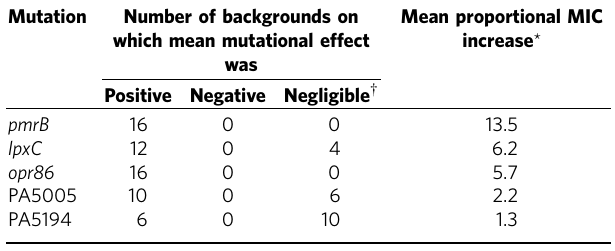
*Geometric mean across all 16 alleles. w Z 2-fold changes in minimum inhibitory concentration (MIC) were considered significant.